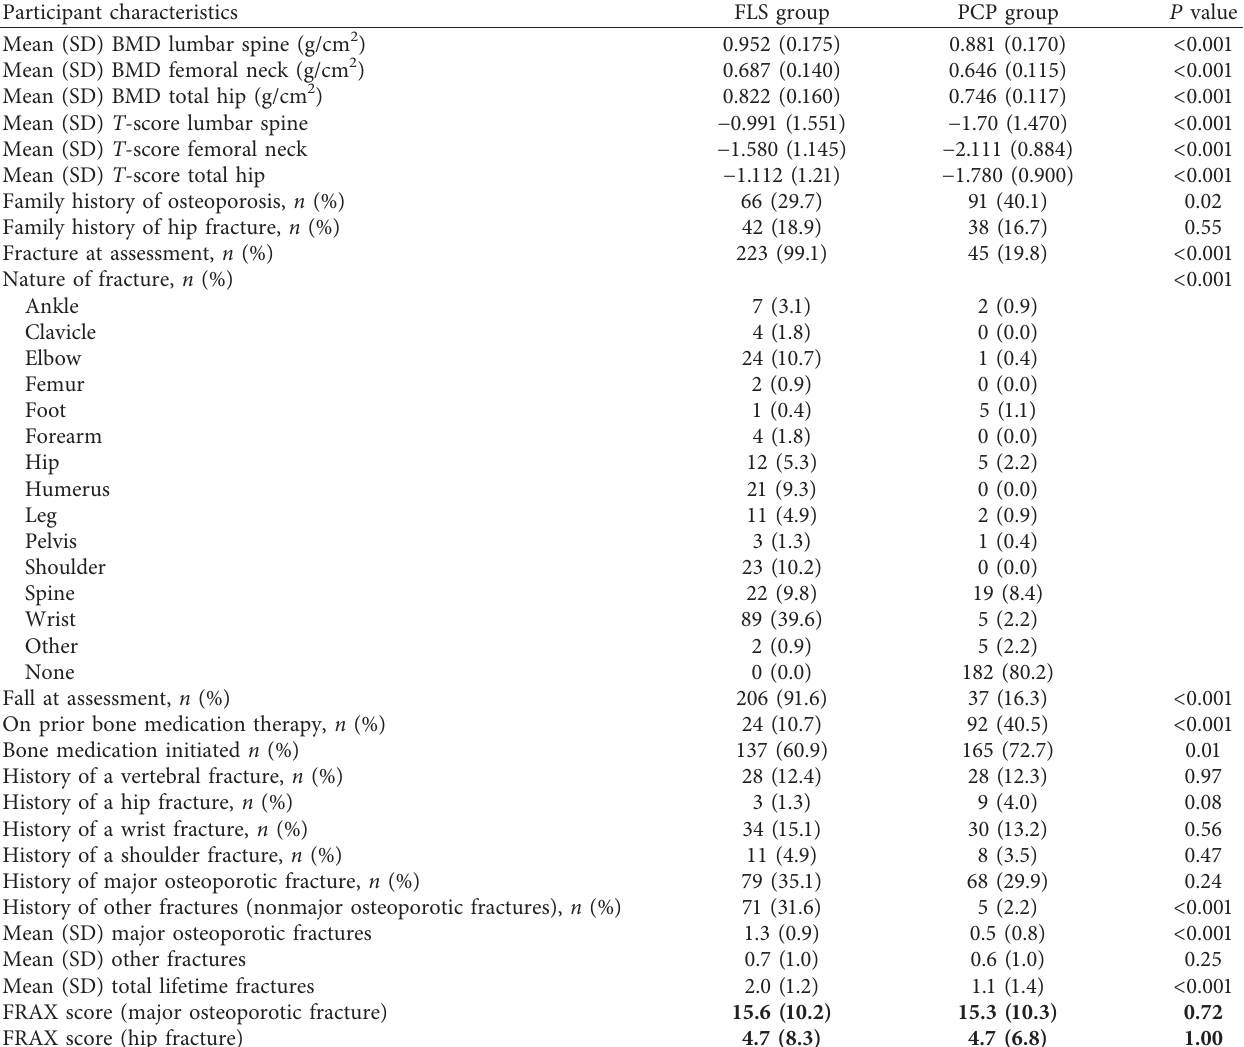
Table 3: Bone mineral density, fracture history, and fracture